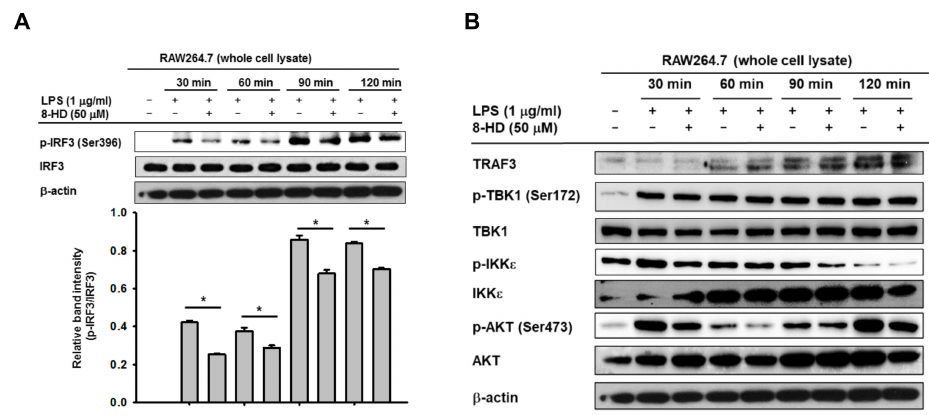
Figure3. 8-HDinhibitsactivationofIRF-3byregulatingupstreamenzymes. RAW264.7cells(2 × 10 6 cells / mL) were pre-treated with 8-HD (50 µ M) for 30 min, followed by incubation with LPS (1 µ g / mL) for the indicated time periods. ( A ) The effect of 8-HD on activation of IRF-3 in LPS-induced RAW264.7 cells. Phospho- and total levels of IRF-3 in total cell lysates were determined by immunoblotting ( B ) The effect of 8-HD on upstream enzymes of IRF-3 signaling (p-AKT, AKT, p-IKK ε , TBK1, p-TBK1, and TRAF3) in the whole-cell lysates were determined by immunoblotting. β -Actin was used as a loading control for whole-cell lysates. ∗ p < 0.05 compared to the control group (LPS